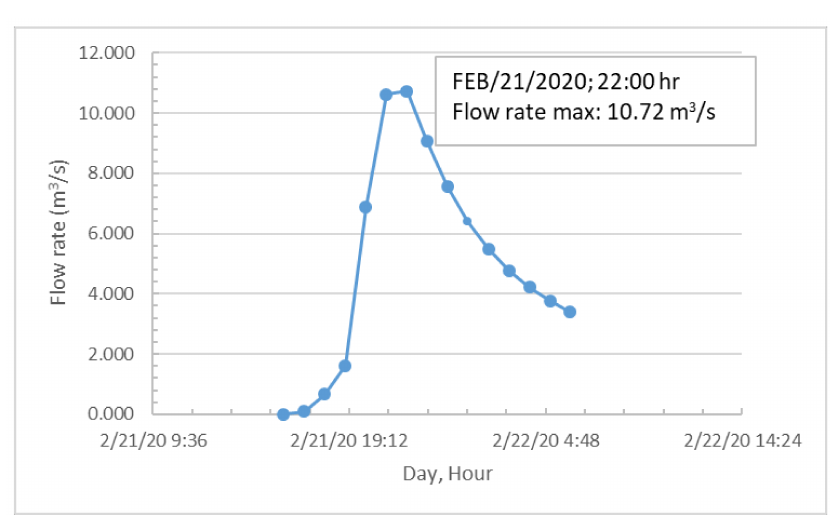
Figure 32. Hydrographs generated by the sub-basins.